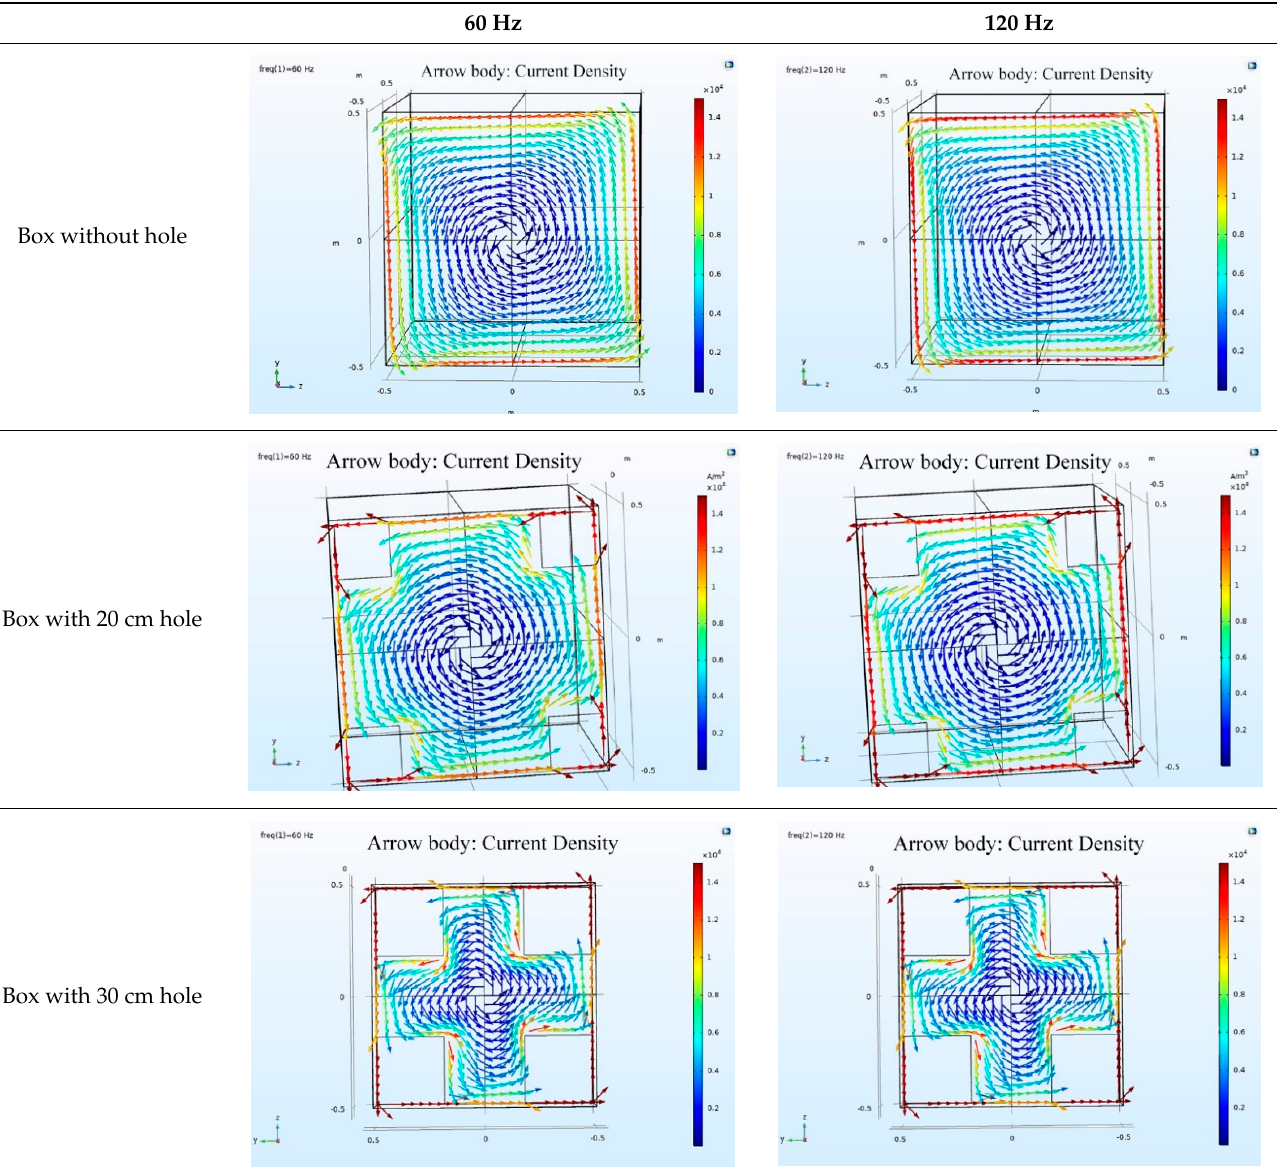
Table 3. The effect of the eddy current in the MSR.